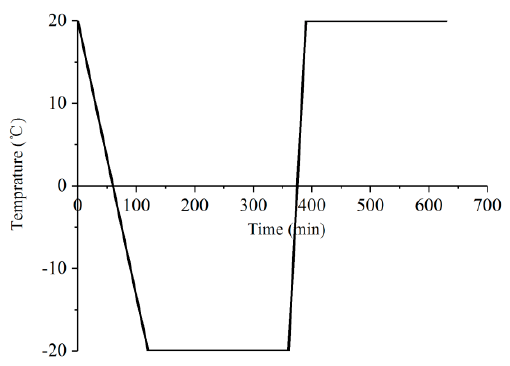
Figure 1. Time-history curve of one FT cycle.